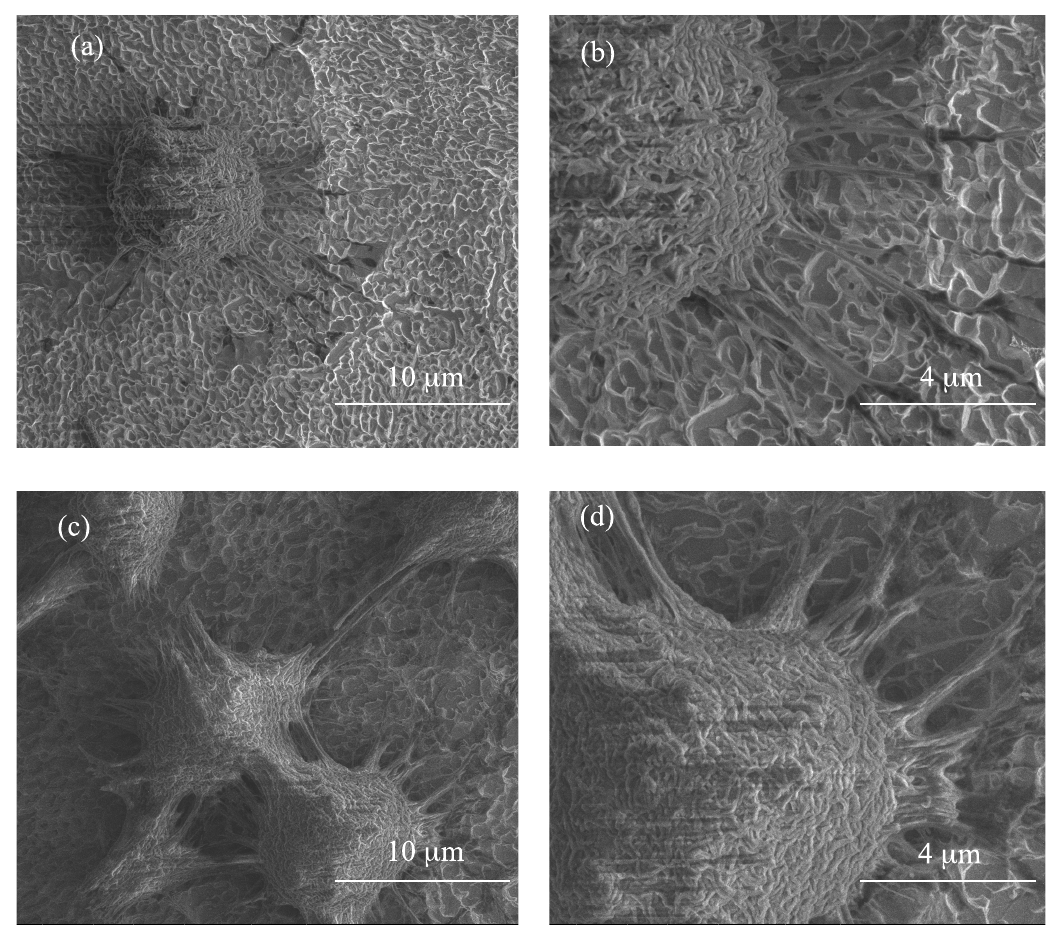
Figure 9. SEM images of L929 murine fibroblasts incubated on the porous titania material surface studied after 24 h ( a , b ) and 120 h ( c , d ).